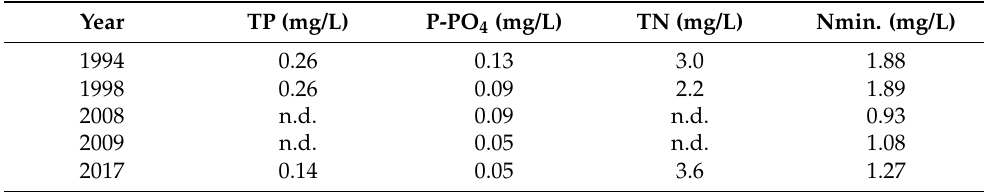
Table 2. Annual average values of nutrients in the Vistula